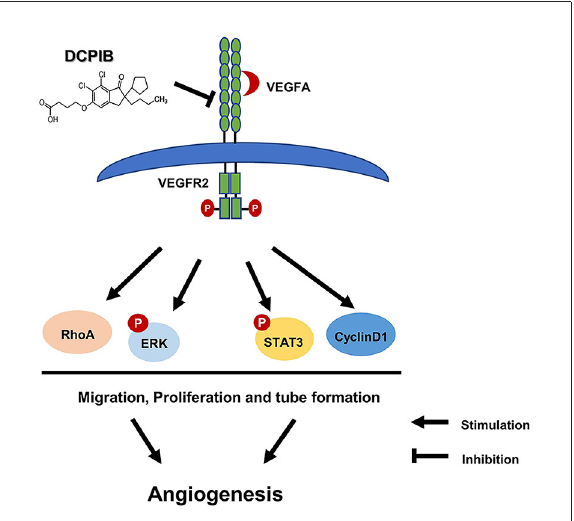
FIGURE8 Schematic diagram of effects of DCPIB on angiogenesis. DCPIB exerted anti-angiogenic effect on HUVECs by inhibiting the activation and expression of VEGFR2 and its downstream mediators including RhoA, CyclinD1, p-ERK and p-STAT3, which lead to decreased migration, proliferation and tube formation in endothelial